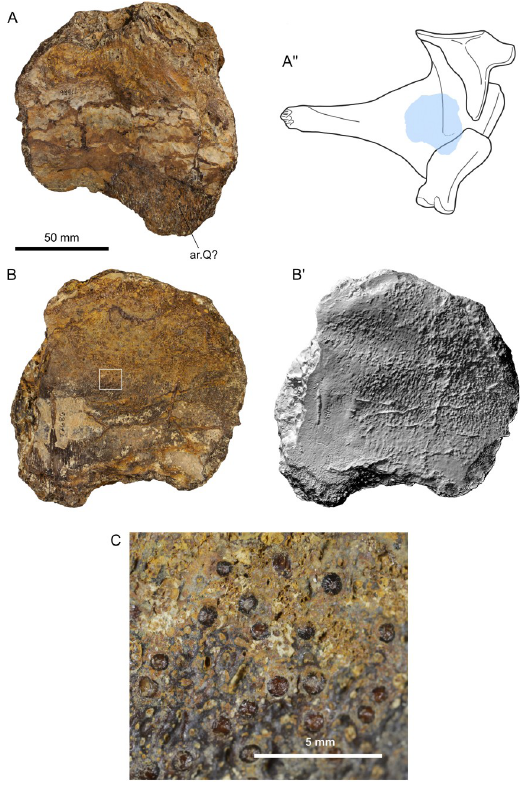
Fig 6. Photographs of a portion of pterygoid (SMU 77686) of Mawsonia sp. from the Woodbine Formation, in lateral (A) and medial (B) views, surface rendering (apostrophe) and schematic drawing (double apostrophes) of a left palatoquadrate in lateral view, indicating the tentative position of the piece (redrawn from Dutel et al. 2014). The area indicated in B (white rectangle) is detailed in the microphotograph of C. Abbreviation: ar.Q, articular surface for